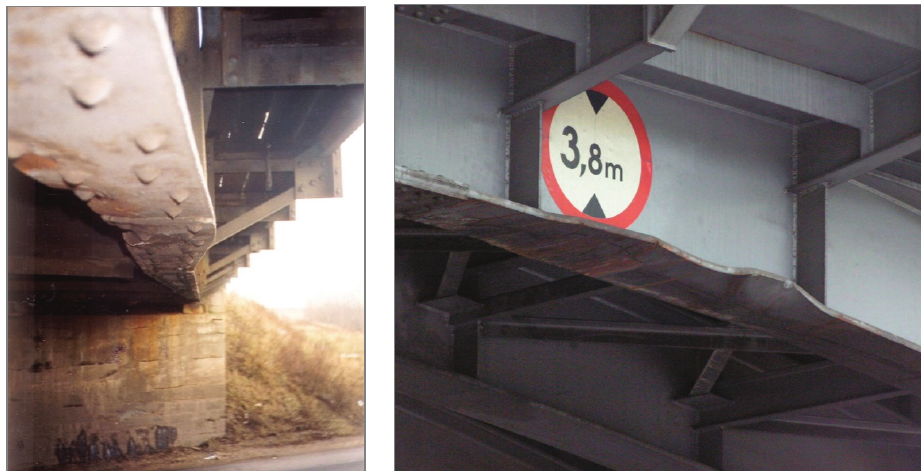
Fig. 2. Deformations of bridge plate